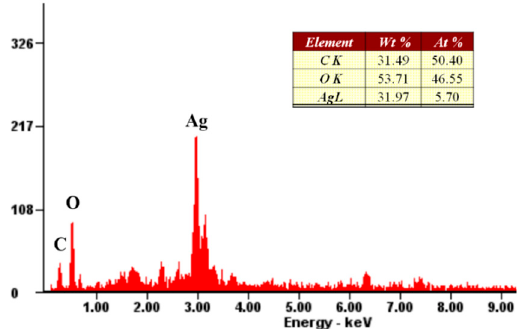
Figure 3. Energy-dispersive X-ray spectroscopy (EDX) spectrum and chemical composition (the inset table) of epirubicin-capped silver NPs.